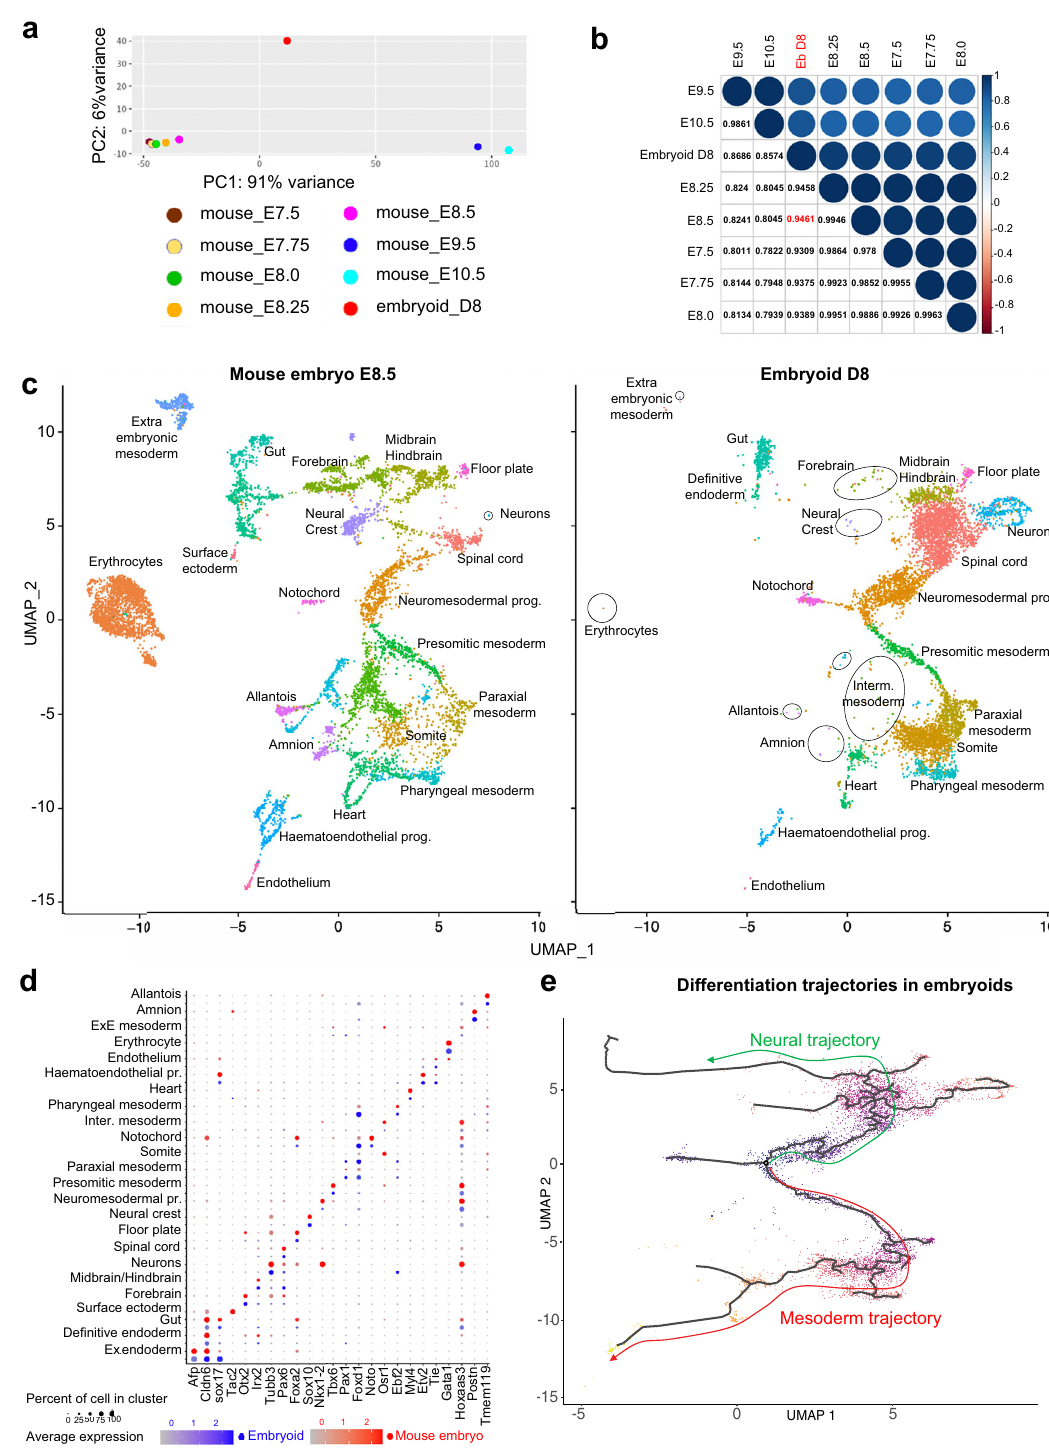
Fig. 8 Comparison of embryoids and of mouse embryos scRNA-seq transcriptomes. a PCA of bulk RNA-seq generated from 5000 randomly selected cells from scRNA-seq of embryoids at D8 and mouse embryos at E7.5, E7.75, E8.0, E8.25, E8.5, E9.5 and E10.5. b Pearson correlation coef fi cient plot for D8 embryoids and mouse embryos in between E7.5 and E10.5 showed the highest correlation between the transcriptome of D8 embryoids (ebD8) and of E8.5 mouse embryos. c UMAP plots showing 6639 cells isolated from D8 embryoids and 8590 cells isolated from E8.5 mouse embryos. A unique colour was used to show cells of each cluster (prog.: progenitors, Inter.: intermediate). The surface ectoderm cluster was only present in mouse embryos. Clusters with a small number of cells were delineated by circles or by an oval line. d Dot plot graph showing both the percentage of cells (diameter of the dot) of a given cluster that expressed the marker gene of that cluster and its level of expression (gradient of colour, blue for embryoids, red for mouse embryos). Names of the 24 clusters are given at the left and name of the marker gene for each cluster are given at the bottom. For each cluster, mouse embryo data are given in red top and the embryoid data are given in blue. e Pseudotime differentiation trajectory analysis for neural and mesoderm trajectories in D8